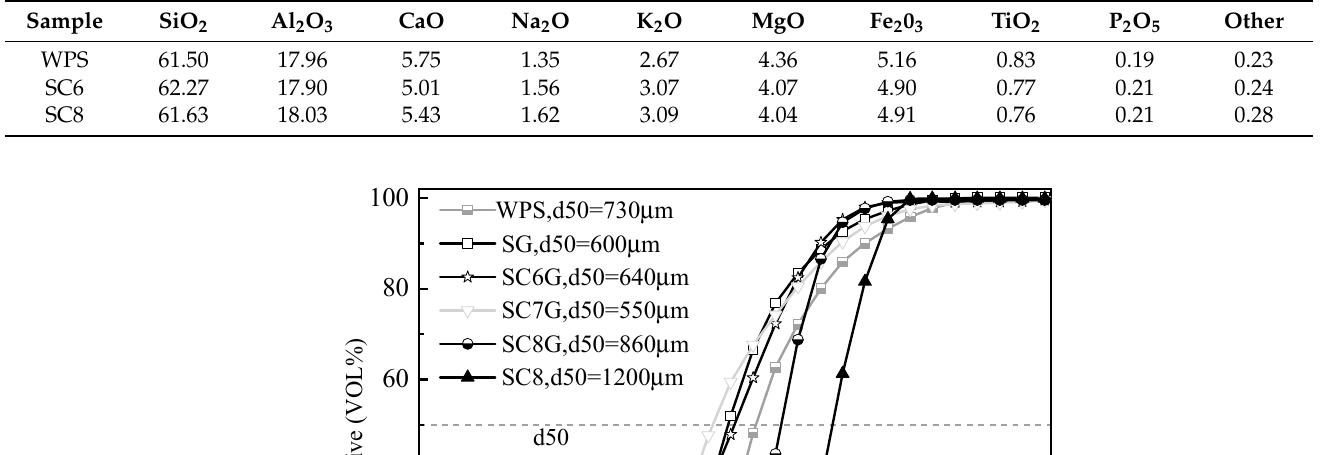
Table 5. Chemical composition of original and thermally activated WPS (%).